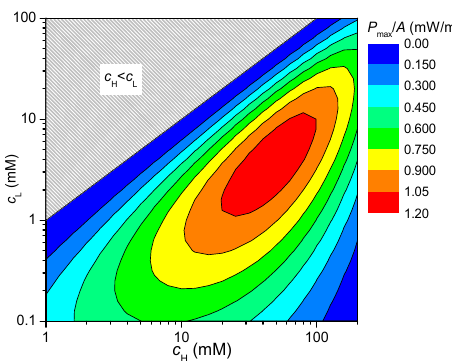
Figure 11. Contour map of maximum power generation density as a function of c L and c H .